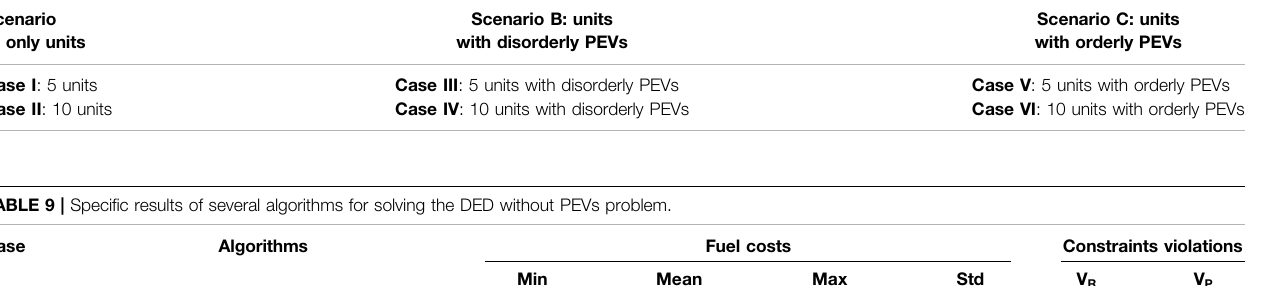
TABLE 8 | Six cases in three scenarios designed to verify the performance of GADMFI in DED with PEVs.